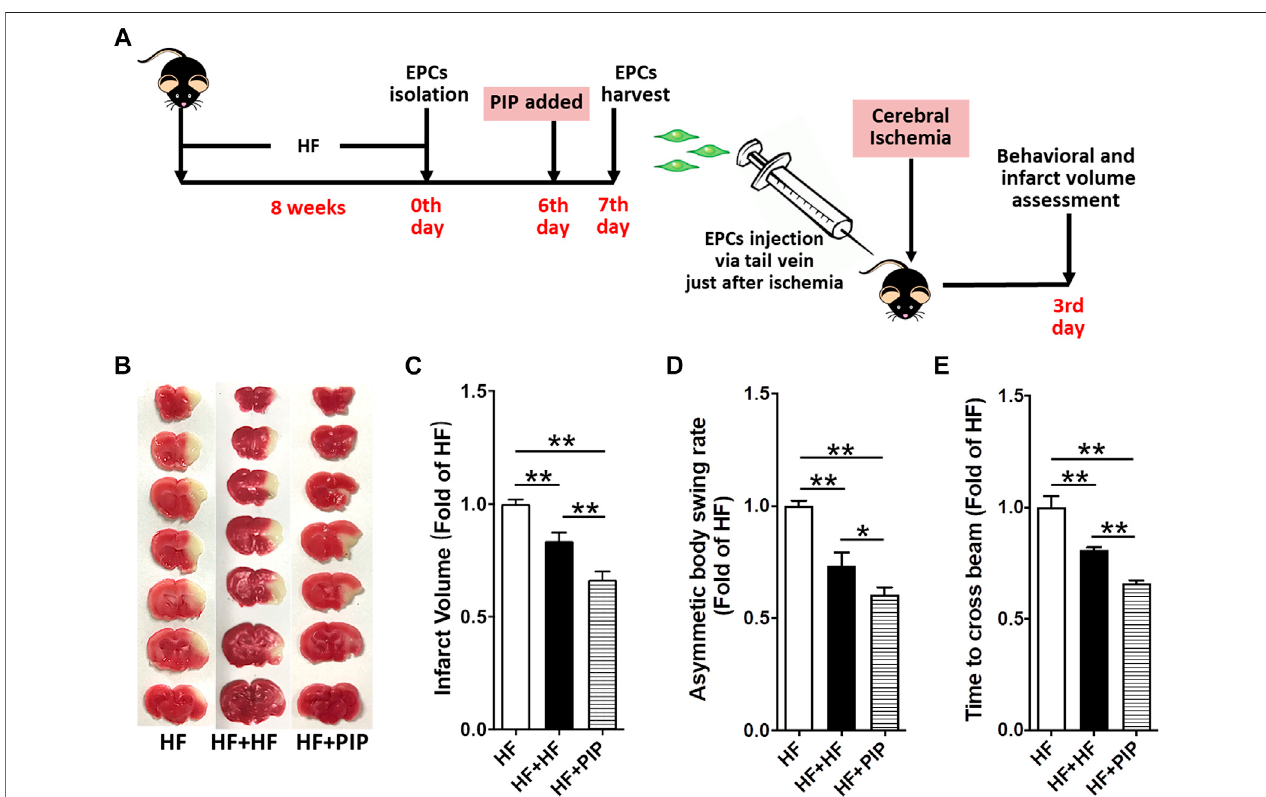
FIGURE5| Incubation withpiperlongumine increased thetherapeuticeffectofEPC fromHFD-fedmice on cerebral ischemic injury reduction in HFD-fed mice. (A) , Surgical protocols: Male C57BL/6 mice (8 weeks) were fed with high-fat rodent chow for 8 weeks. Then, the EPCs were isolated from the HFD-fed mice. After 6 days, piperlongumine (1.0 μ M) wasadded toEPCs for 24 h. EPCs were harvested at the 7 th day and injected intothe HFD-fed mice via tail vein justafter the cerebral ischemia (1 × 10 6 EPCs per mice). Behavioral test and the infarct volumes were assessed on day 3 after middle cerebral artery occlusion. (B,C) , Images are representativeof 2,3,5-triphenyltetrazolium chloride-stained brain sections (B) and cerebral infarct volumes (C) . (D,E) , Neurobehavioral outcomes: Body Asymmetry Test (D) and Beam Test (E) .Throughout, bars represent means;error bars represent SEM.Values werenormalizedtoHF. * p < 0.05,** p < 0.01.n (cid:2) 8-9per group. HF,HFD-fedmice; HF+ HF, HFD-fed mice treated with EPCs; HF + PIP, HFD-fed mice treated with piperlongumine (1.0µM, 24 h)-incubated